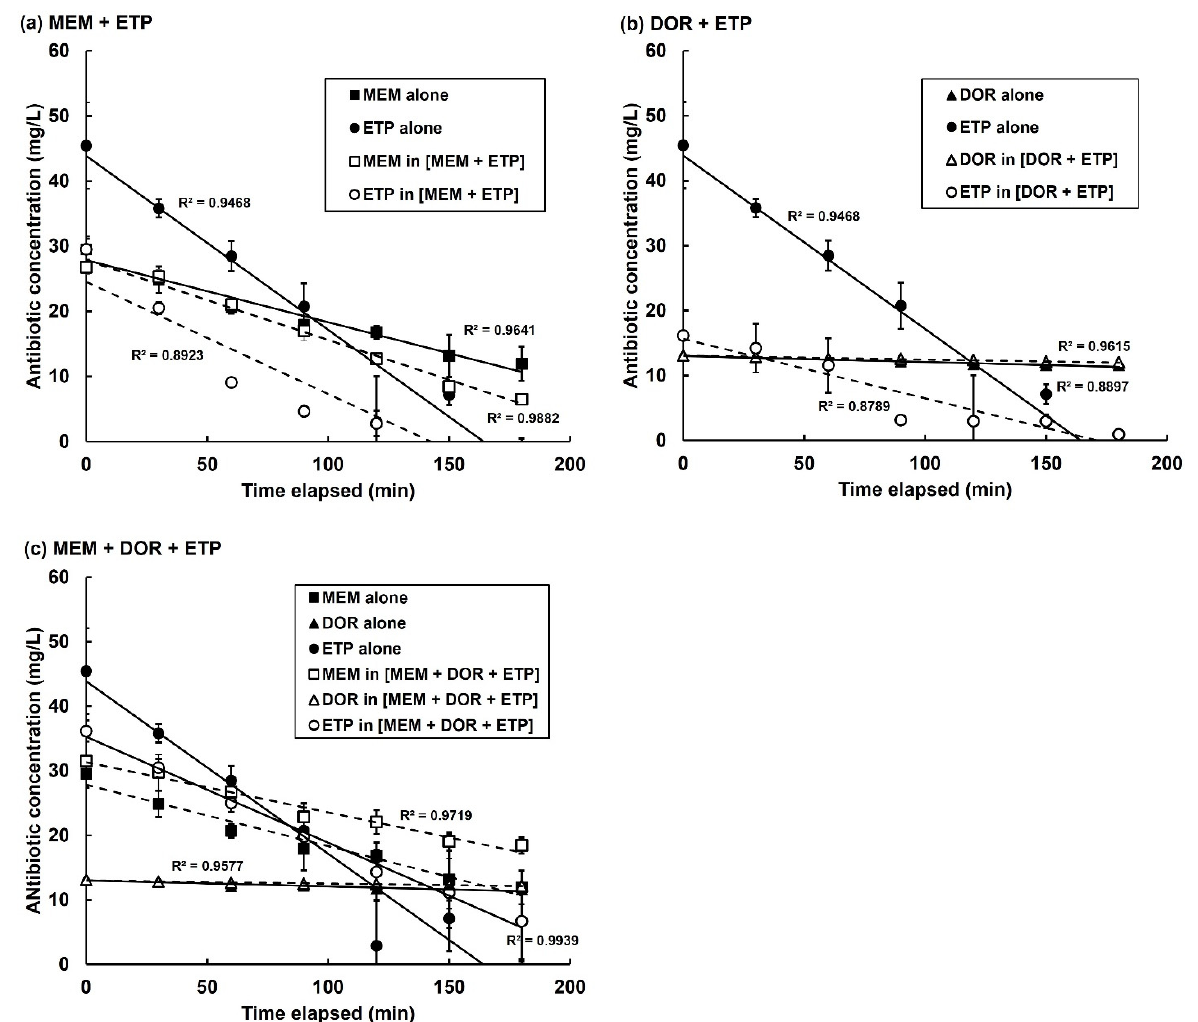
Figure 7. Decline in concentration of individual carbapenems either alone or in combination in the presence of P. aeruginosa NCTC13437. Antibiotic concentrations were measured using LC-MS. Carbapenems present in three combination treatments were studied: MEM + ETP, DOR + ETP and MEM + DOR + ETP. Carbapenem concentrations in PBS were—MEM—64 mg/L, DOR—32 mg/L and ETP—256 mg/L. Following this, 2.5 × 10 3 cfu/mL of P. aeruginosa cells, washed and resuspended in PBS, were added and the change in concentration of each carbapenem alone, or in combination, was measured over a period of three hours at 37 ◦ C. The experiment was performed in duplicate and the mean ± SEM is shown. Linear regression with R 2 values for each condition are